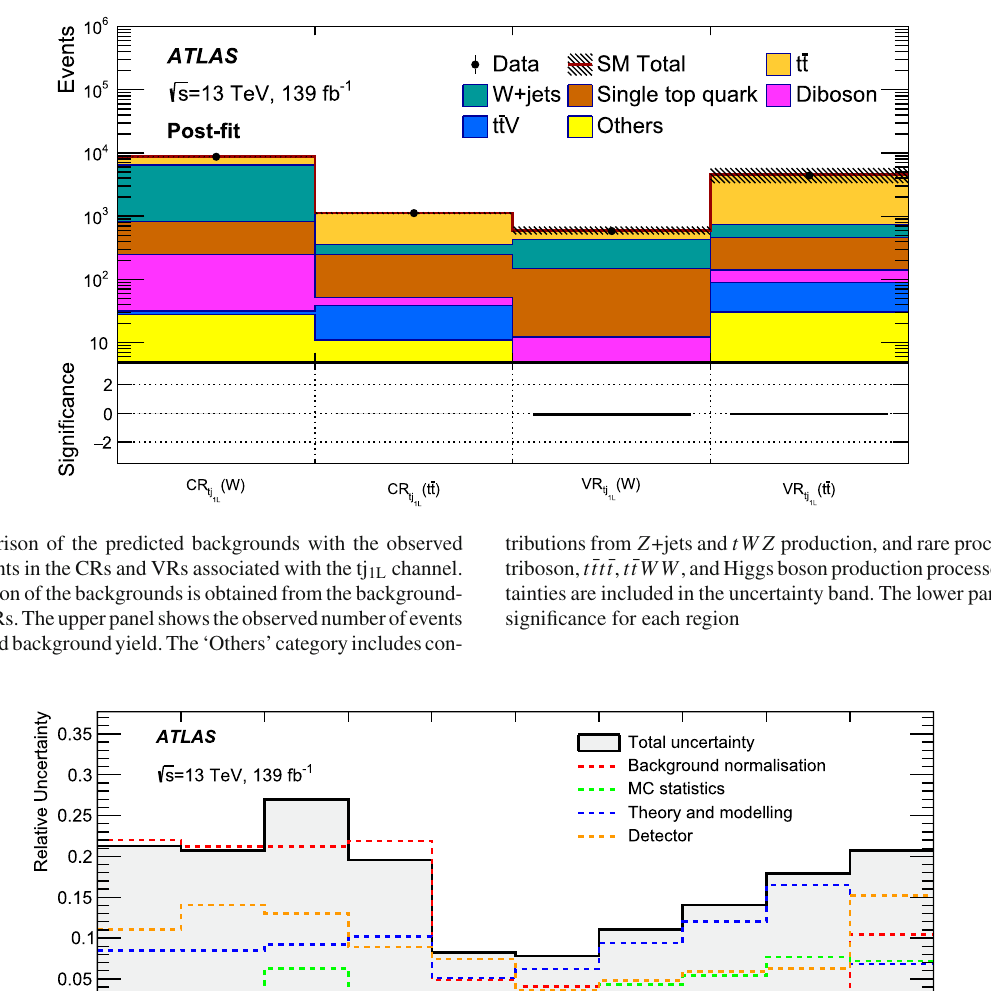
sents the uncertainty in the fitted normalisation factors, including the available event counts in the CRs. Individual uncertainties can be corre- lated,anddonotnecessarilyaddupinquadraturetothetotalbackground